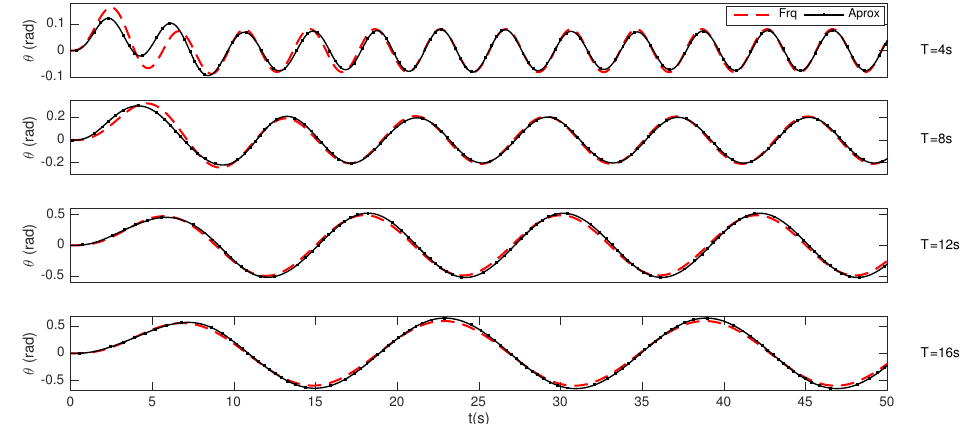
Figure 8. Amplitude of oscillations of the flap with time for different wave frequencies (Solution of Equation (4), dotted line; Solution of Equation (25), solid